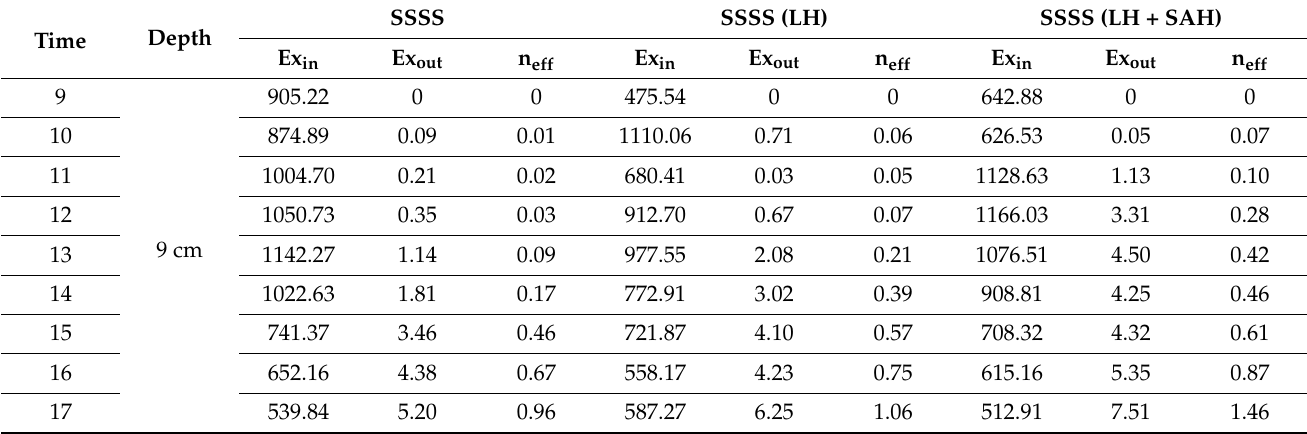
Table 5. Exergy analysis of SSSS, SSSS (LH) and SSSS (LH + SAH) at the depth of 9 cm.